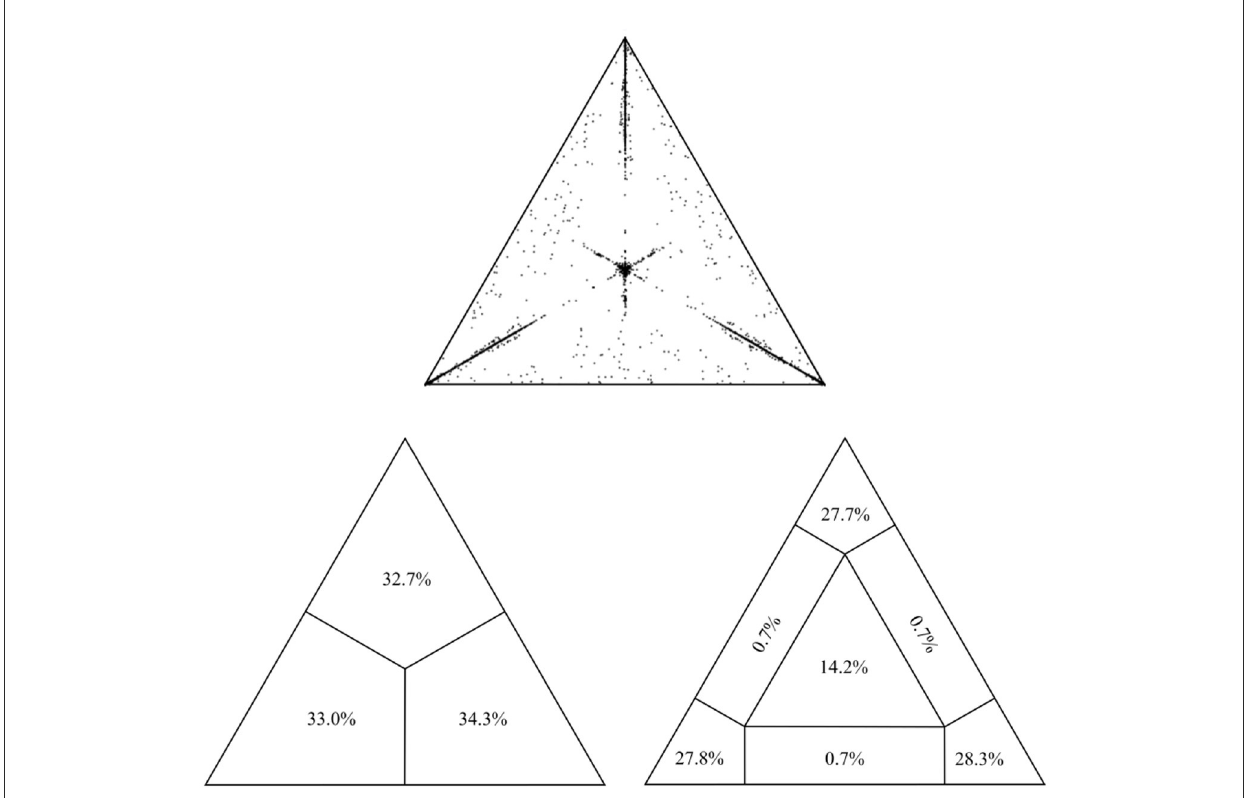
FIGURE1 Assessment of the phylogenetic noise of the dataset through the likelihood mapping method implemented in the program TreePuzzle, suggesting sufficient phylogenetic information within the alignment.